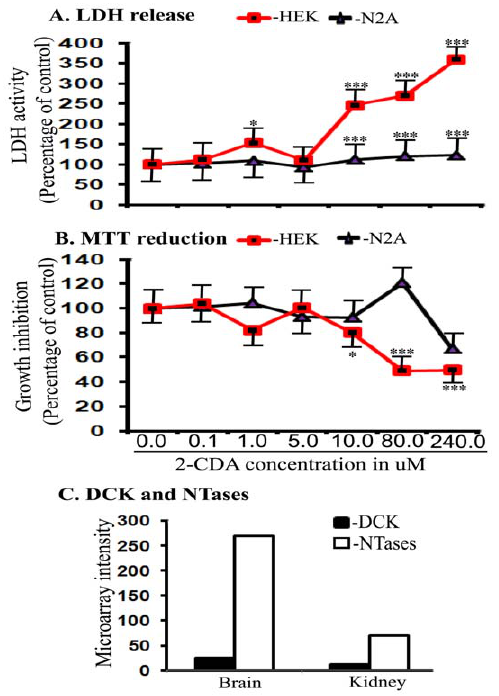
Figure 5. 2-CDA is cytotoxic at high concentrations. (A) LDH release was measured as an indicator of cytotoxicity in HEK 293 cells and N2A cells after incubation with different concentrations of 2-CDA as indicated. Significant cytotoxicity was observed at 1.0 m M (p , 0.05), 10.0 m M (p , 0.001), 80.0 m M (p , 0.001) and 240.0 m M (p , 0.001) in HEK 293 cells. Similarly in N2A cells significant toxicity was observed at 10.0 m M (p , 0.001), 80.0 m M (p , 0.001) and 240.0 m M (p , 0.001). (B) MTT reduction assay, however indicated significant toxicity only in HEK 293 cells at 10.0 m M (p , 0.05), 80.0 m M (p , 0.001) and 240.0 m M (p , 0.001), but 2-CDA was nontoxic in N2A cells even at high concentrations. (C) the calculated DCK activity was almost one-fold higher in the brain compared to kidneys. But kidneys showed almost three-fold increased 5 9 -NTases activity compared to whole brain tissue. For all samples in A and B, n=4. *, p , 0.05, **, p , 0.01, ***, p , 0.001 versus controls by ANOVA followed by Tukey-Kramer multiple comparison test.